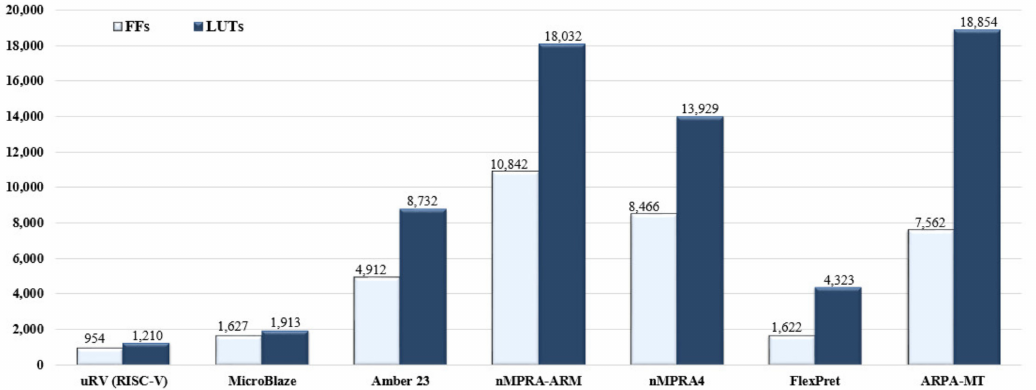
Figure 1. FPGA resourcesusedforimplementingtheprocessorsdescribedintheliterature(uRV(RISC-V) [4], MicroBlaze [13], Amber 23 [14], nMPRA-ARM [19], nMPRA4 [6], FlexPret [17], ARPA-MT